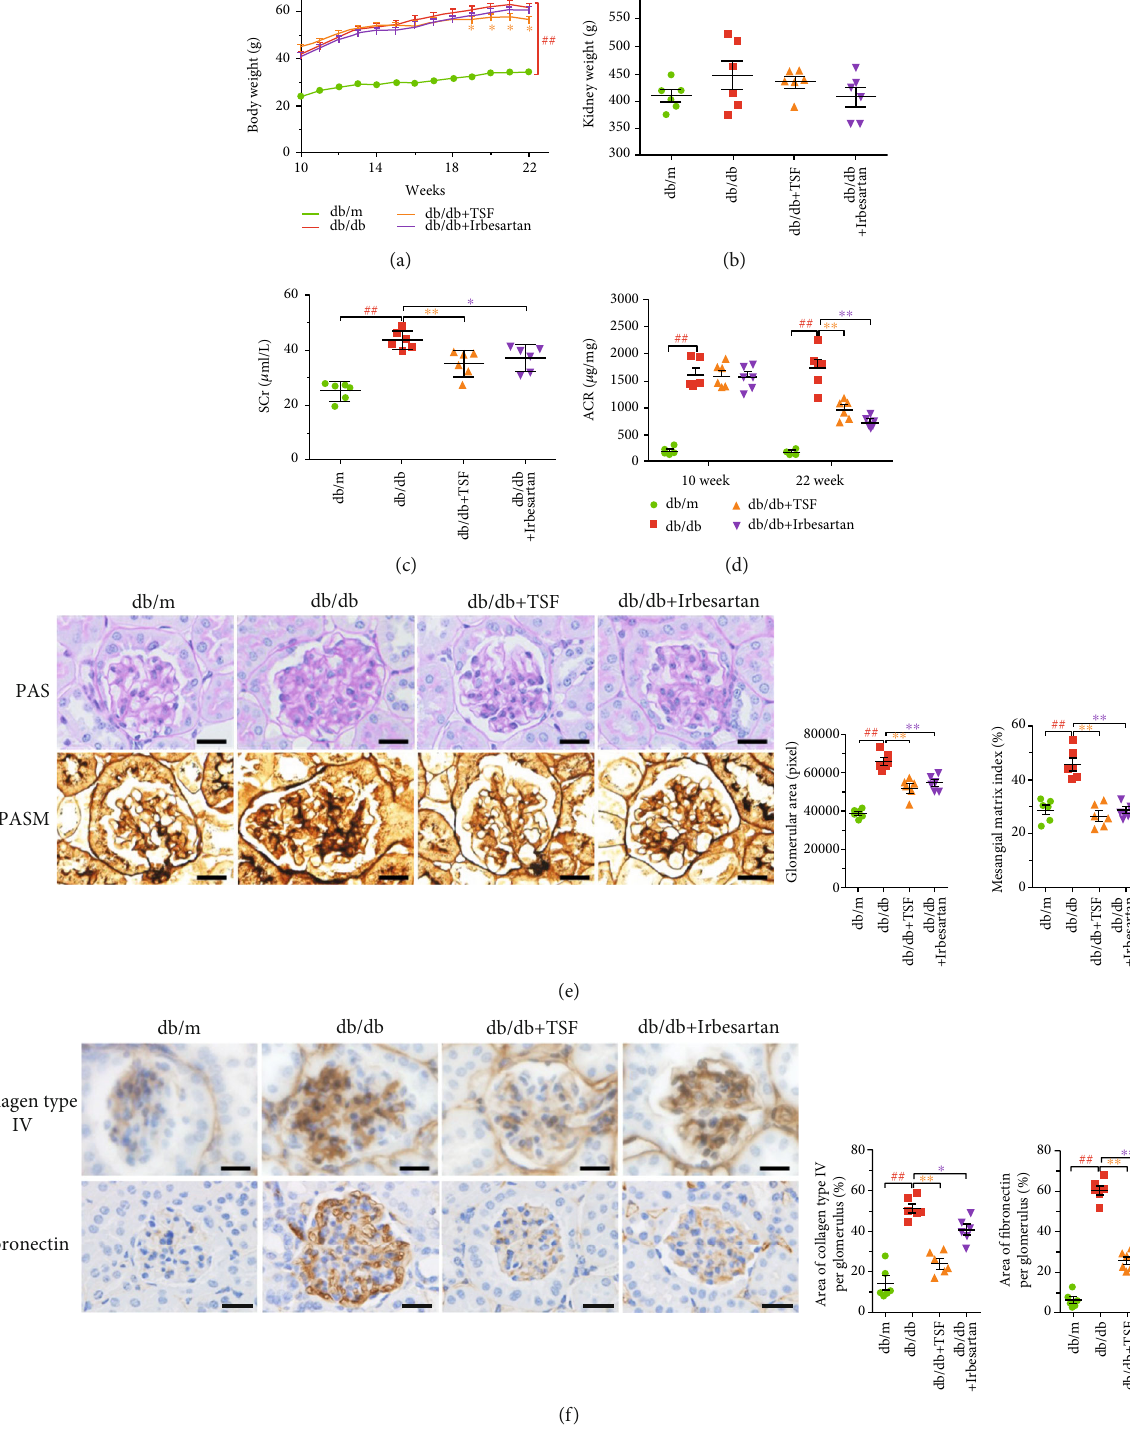
Figure 1: TSF reduced proteinuria and alleviated renal injury in db/db mice. (a) Body weight was recorded each week ( n = 6 ). (b) Kidney weight of mice in each group at 22 weeks of age ( n = 6 ). (c) Urinary albumin to creatinine ratio (ACR) ( n = 6 ). (d) Serum creatinine in each group ( n = 6 ). (e) Representative PAS staining (scale bars, 20 μ m) and quantitative analysis of glomerular hypertrophy and mesangial expansion ( n = 6 ); representative PASM staining (scale bars, 20 μ m). (f) Representative immunohistochemical staining and quantitative analysis of collagen type IV and fi bronectin (scale bars, 20 μ m) (20 glomeruli were randomly evaluated per section) ( n = 6 ). The data were expressed as the mean ± SEM . # P < 0 : 05 , ## P < 0 : 01 vs. db/m group; ∗ P < 0 : 05 , ∗∗ P < 0 : 01 vs. db/db group. Statistically analyzed via a one- way ANOVA with Dunnett ’ s